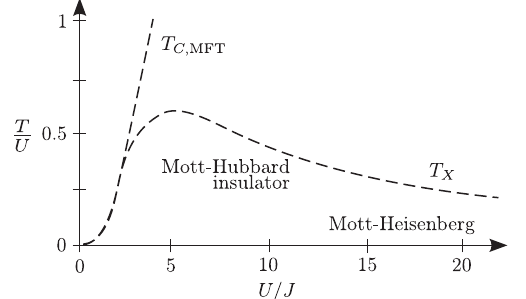
FIG. 3. Schematic phase diagram of the 2D Hubbard model at half-filling (based on Fig. 2 from Ref. [60]). T temperature computed from the gap equation, Eq. (29). T the temperature at which the crossover from short-range to (quasi-)long-range order